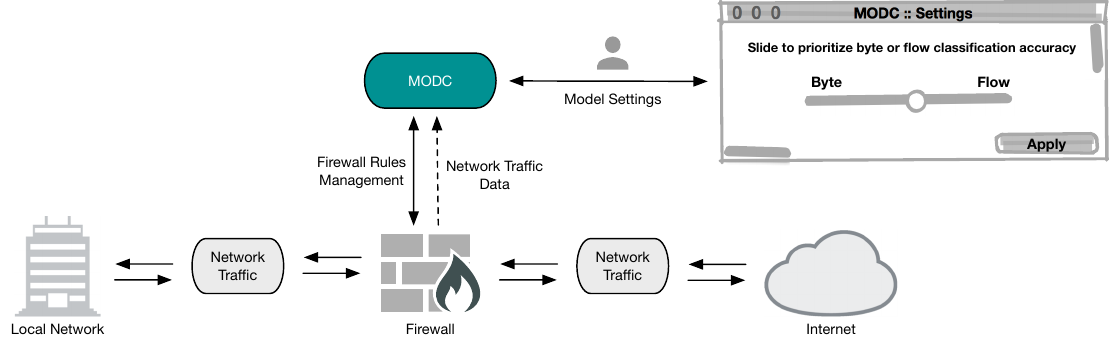
Figure 7. Exemplification of a simplified decision process performed by a network administrator.